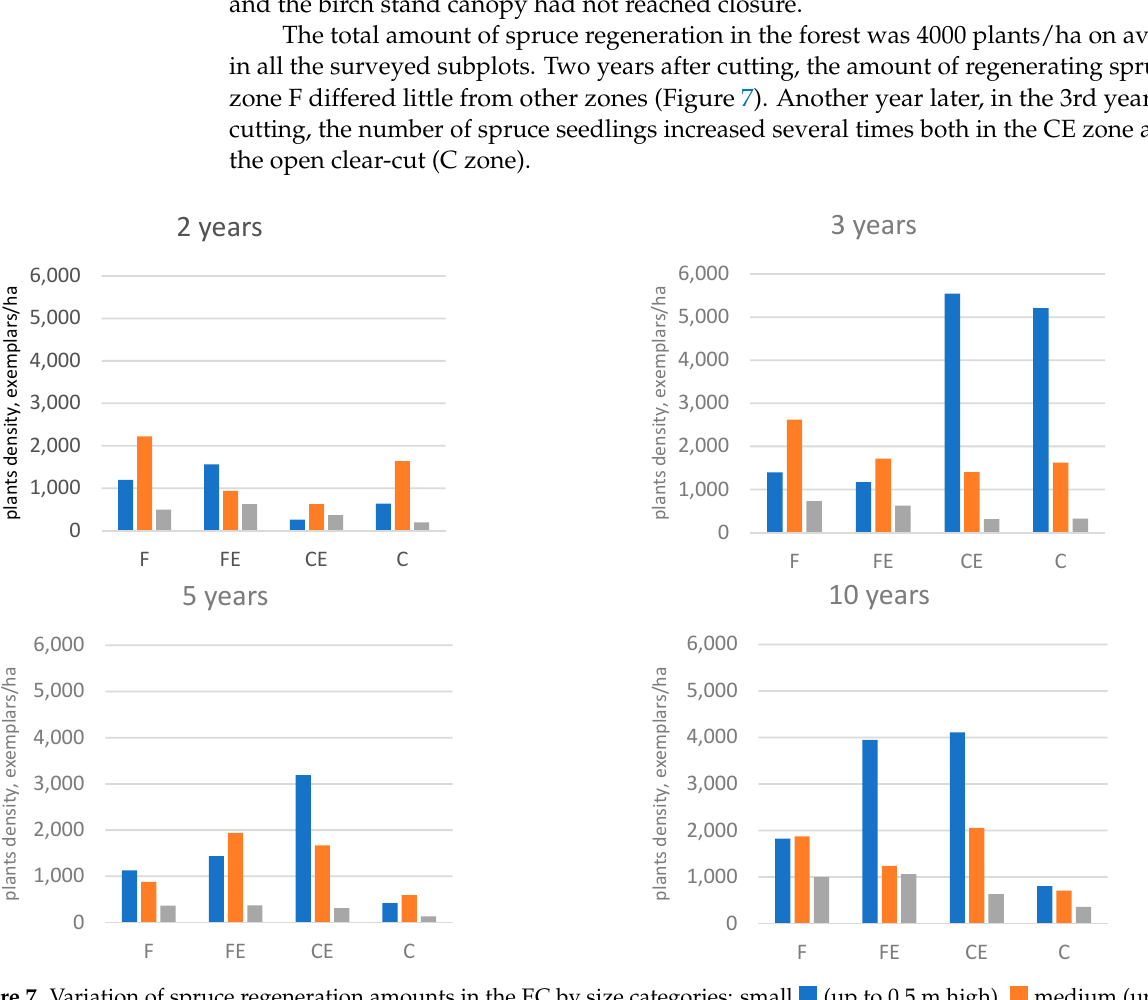
Figure 7. Variation of spruce regeneration amounts in the EC by size categories: small (up to 0.5 m high), medium (up to 1.5 m high), and large (higher than 1.5 m). Means values and standard errors are shown.